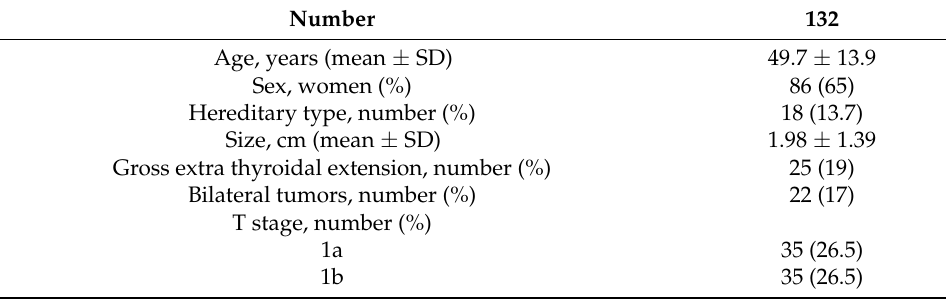
Table 1. Baseline characteristics of the study